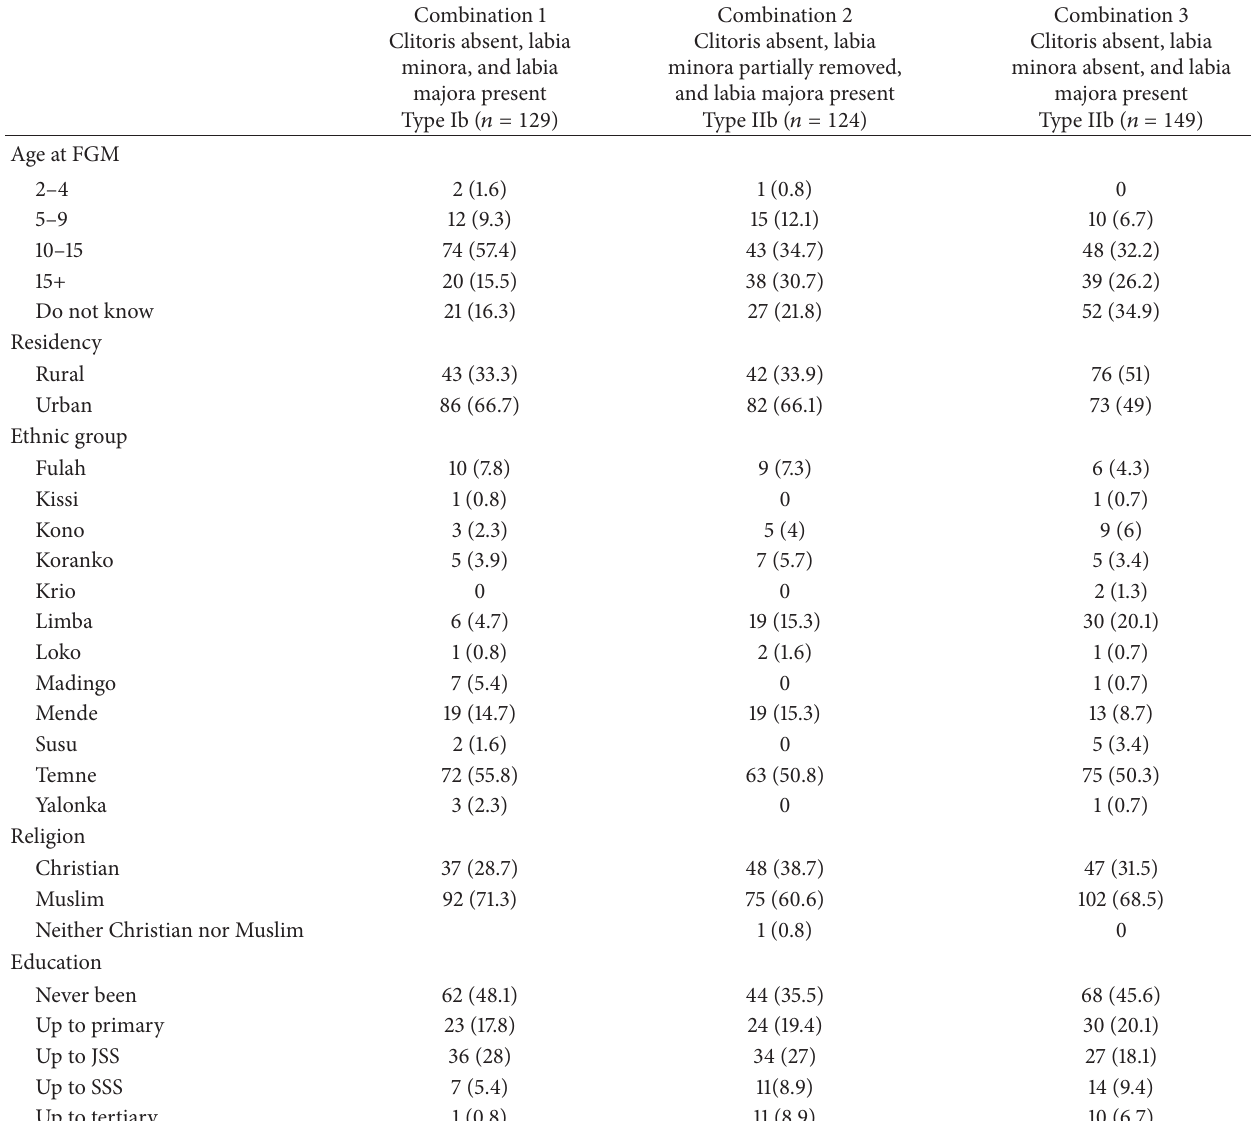
Table 5: Three most frequent combinations of anatomical description alterations versus sociodemographic factors.